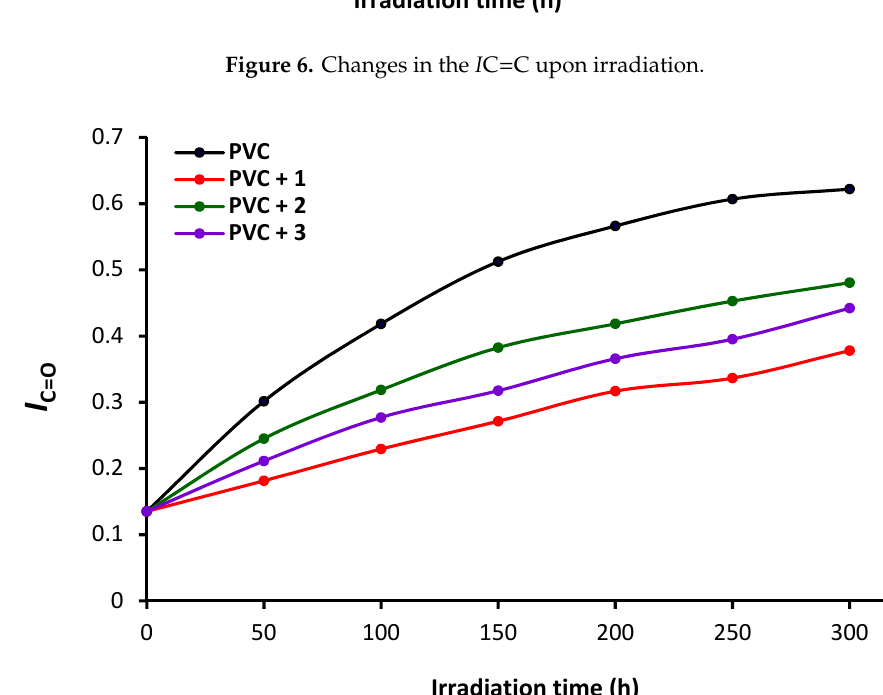
Figure 7. Changes in the I C = O upon irradiation.